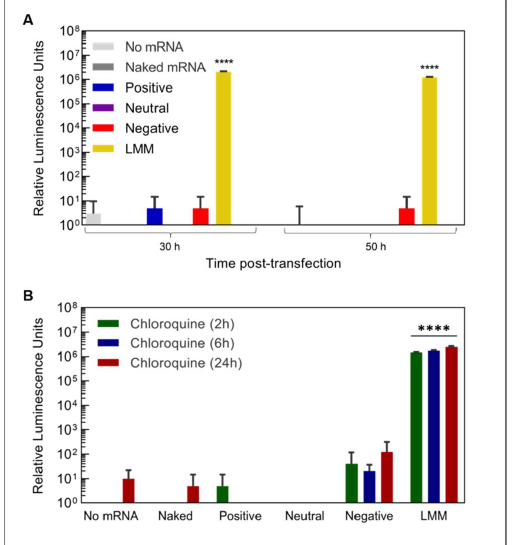
Figure 6. mRNA expression and endosomal release. Expression of luciferase protein ( A ) 30 h and 50 h after transfection with luciferase mRNA loaded on differently charged gelatin nanoparticles or commercial lipoplexes (LMM) and ( B ) 30 h after transfection with the stimulation of endosomal escape by the addition of chloroquine at different time points ( n = 4). **** indicates statistically significant differences compared to the untransfected control (no mRNA) with p < 0.0001.